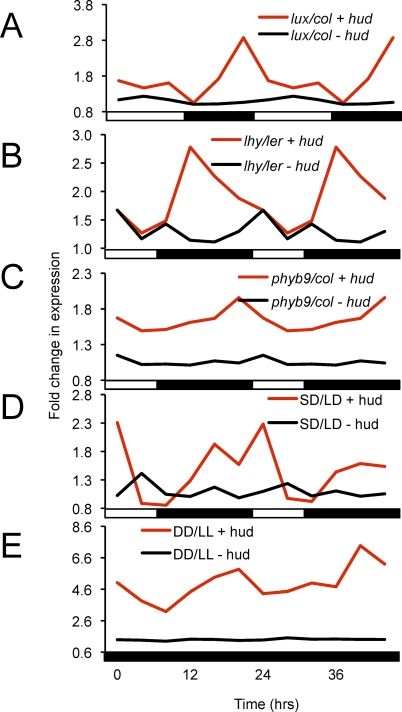
The Growth-Associated Phytohormone Genes Are Linked to Dark-Induced Growth RegulationTo determine the time-dependent behavior of the growth-associated phytohormone genes controlled by the HUD element, the average fold increase between mutant and wild type for each time point is presented (red lines). As a control, the average fold changes for the phytohormone genes not associated with growth that do not contain an HUD element are also presented (black lines). In circadian mutants, phytohormone transcript abundance increases during the dark period compared to wild type, whereas it is constantly higher at any time of the day in phyB mutant.(A) lux-2 versus Ler under intermediate-day photoperiods (12-h light/12-h dark).(B) lhy versus Col under short-day photoperiods (8-h light/16-h dark).(C) phyB-9 versus Col under short-day photoperiods.(D) Short-day versus long-day photocycles.(E) Continuous dark (DD) versus continuous light (LL) [19].One-day (six time point) time courses are double plotted for visualization purposes. Black bars represent the dark period. Bars at the bottom of each graph represent light/dark cycle.